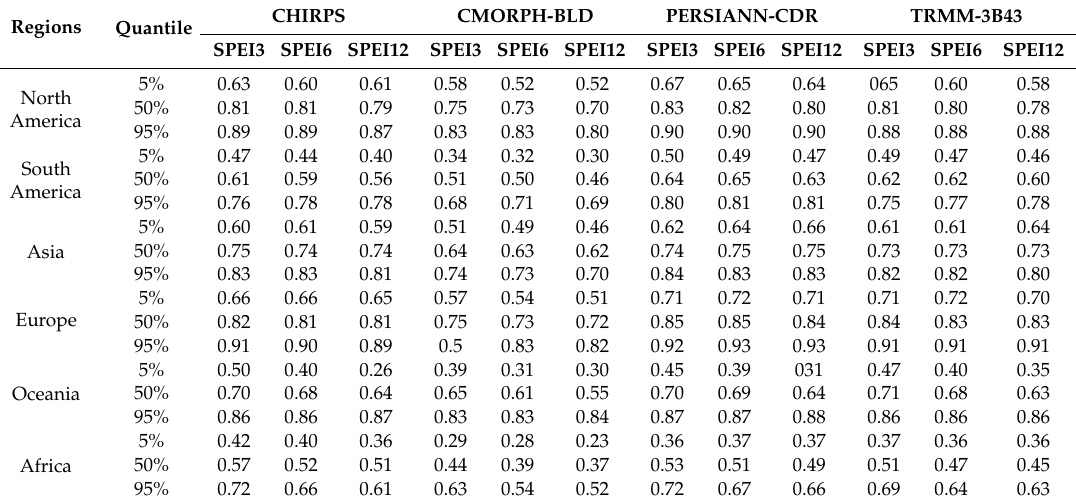
Table 4. 5%, 50%, and 95% quantiles of the monthly SPEI CC for six regions from 2000 to 2016.